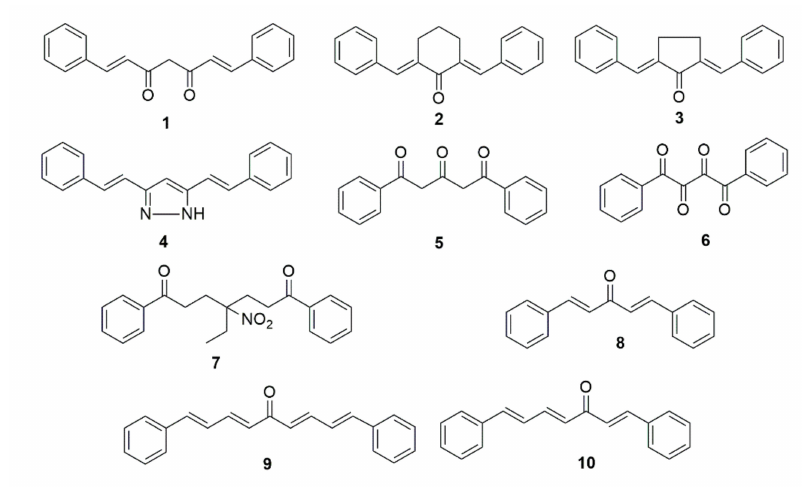
Figure 1. Structures of curcumin analogues used in this